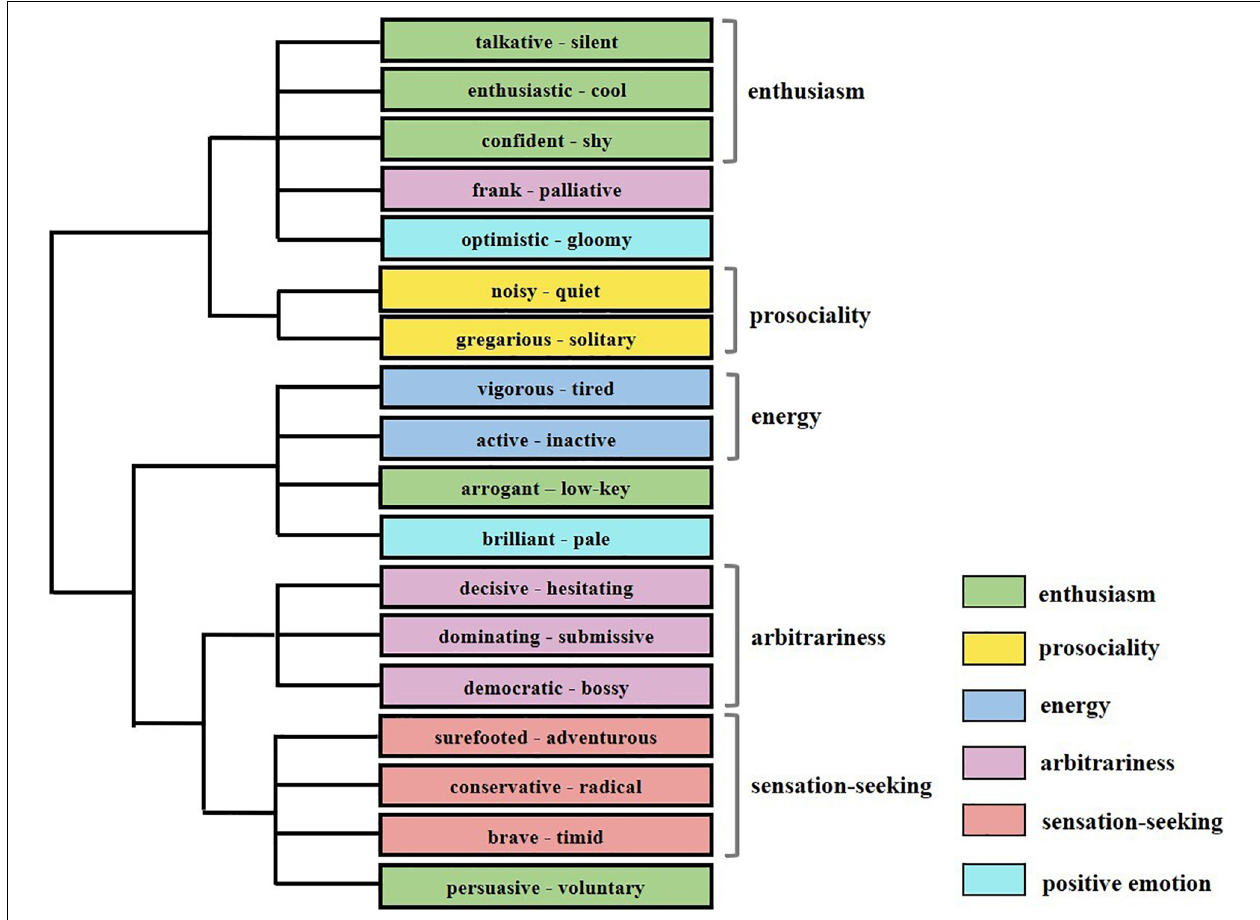
FIGURE 4 | The word group frank – palliative was not clustered into arbitrariness . The pairs optimistic – gloomy and brilliant – pale were not clustered into positive emotion, which was not distinguished in the results. Arrogant – low-key was not clustered into enthusiasm. Colors denotes word groups’ categories in the Big Five personality